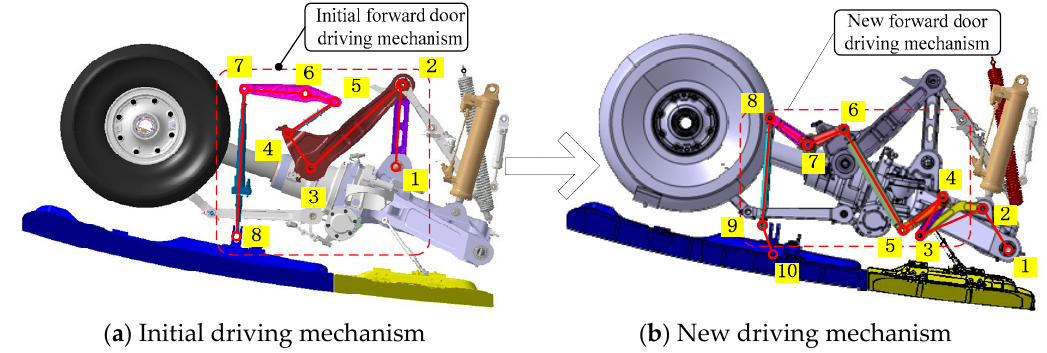
Figure 7. New driving mechanism and force transmission path of forward door.